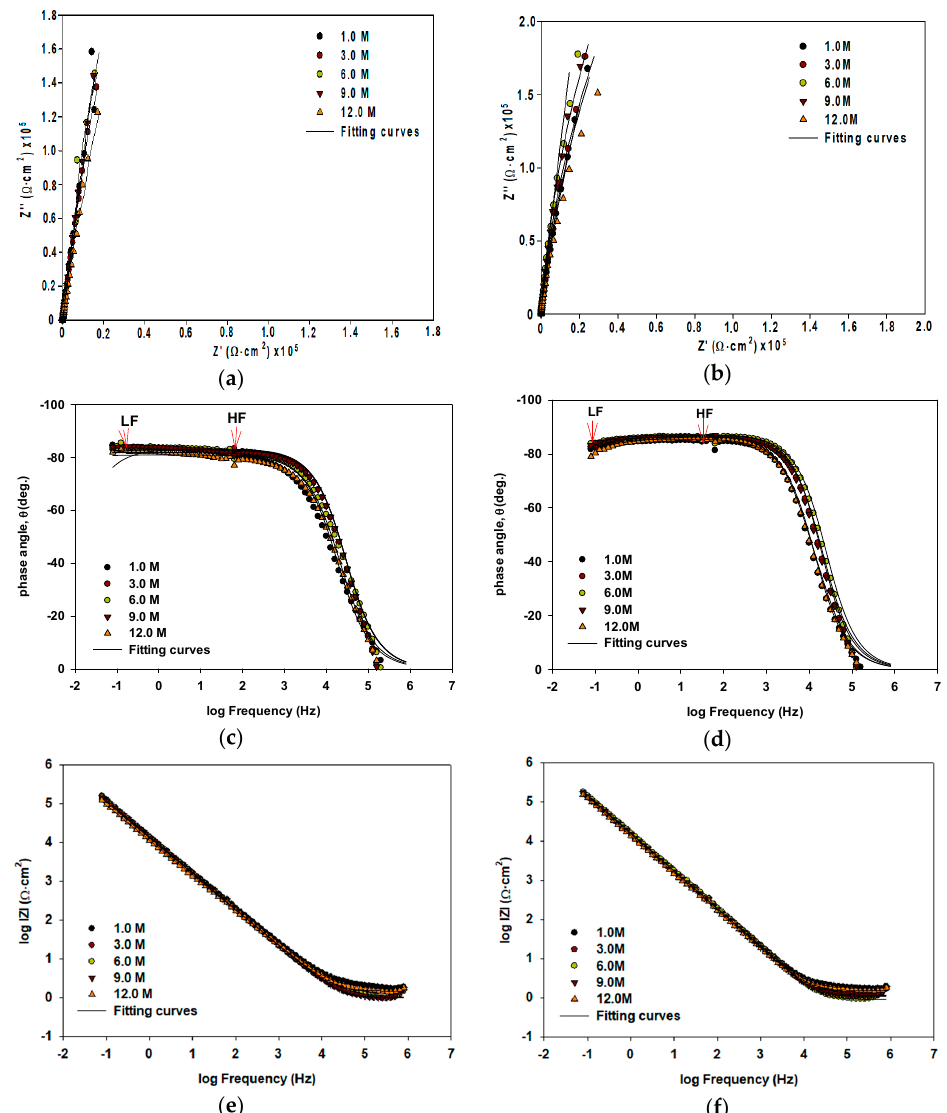
Figure 2. Impedance plots of Ni-base glassy alloys VZ1 (left) and VZ2 (right) in different concentrations of NaOH at 27 °C: ( a , b ) Nyquist spectra; ( c , d ) Bode phase plots; ( e , f ) Bode magnitude plots. Metals 2018 , 8 , 64